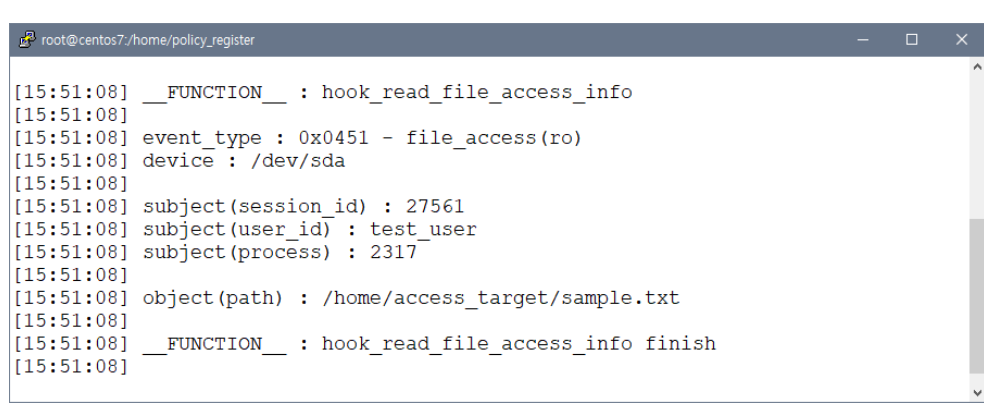
Figure 6. File access event check verification.